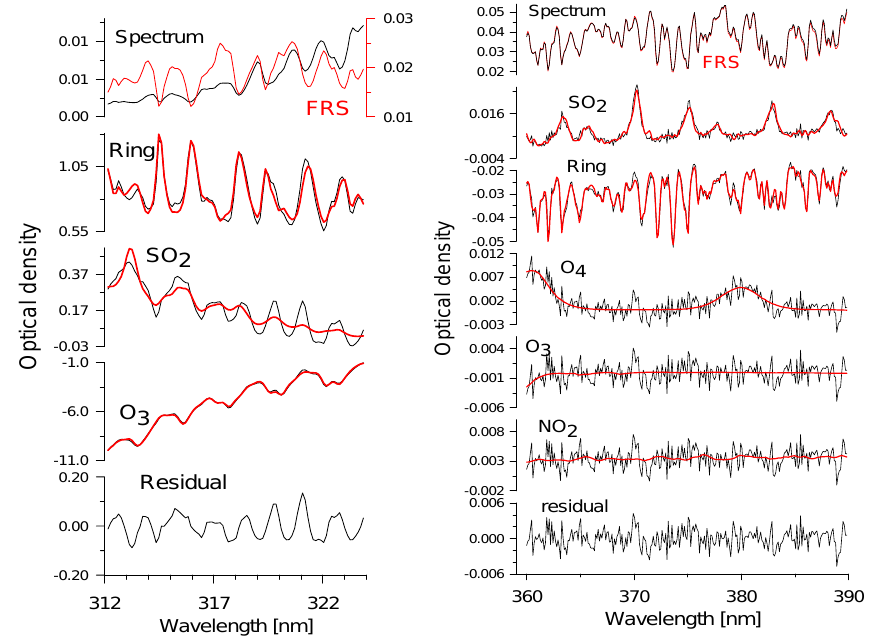
Fig. 2. Example of a DOAS SO 2 -Fit. Black lines: measured spectra, red lines: reference spectra, the atmospheric spectrum was taken by GOME-2 (21:25UTC, center pixel coordinates 167.88 ◦ W 49.69 ◦ N) on the 8 August 2008 after the eruption of the Kasatochi volcano (a) evaluation in the short wave UV window 312.1–324nm (b) evaluation in the long wave UV window